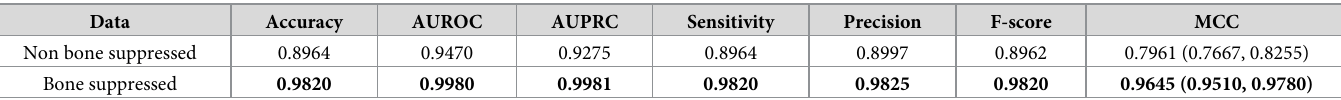
Table 4. Classification performance achieved with the model trained on non-bone-suppressed and bone-suppressed images. Data in parenthesis denote the 95% binomial CI measured as the Exact Clopper Pearson interval for the MCC metric. Bold numerical values denote superior performance in respective columns.